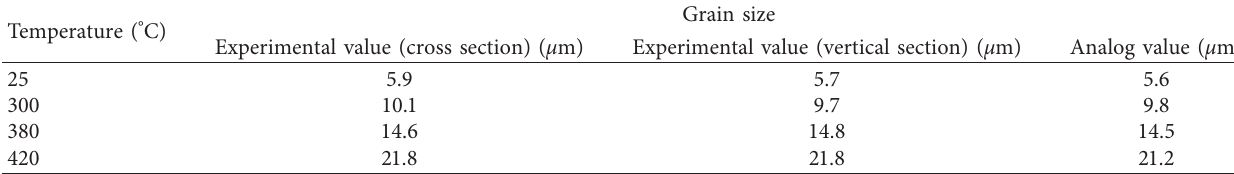
Table 2: The experimental and simulated results at different